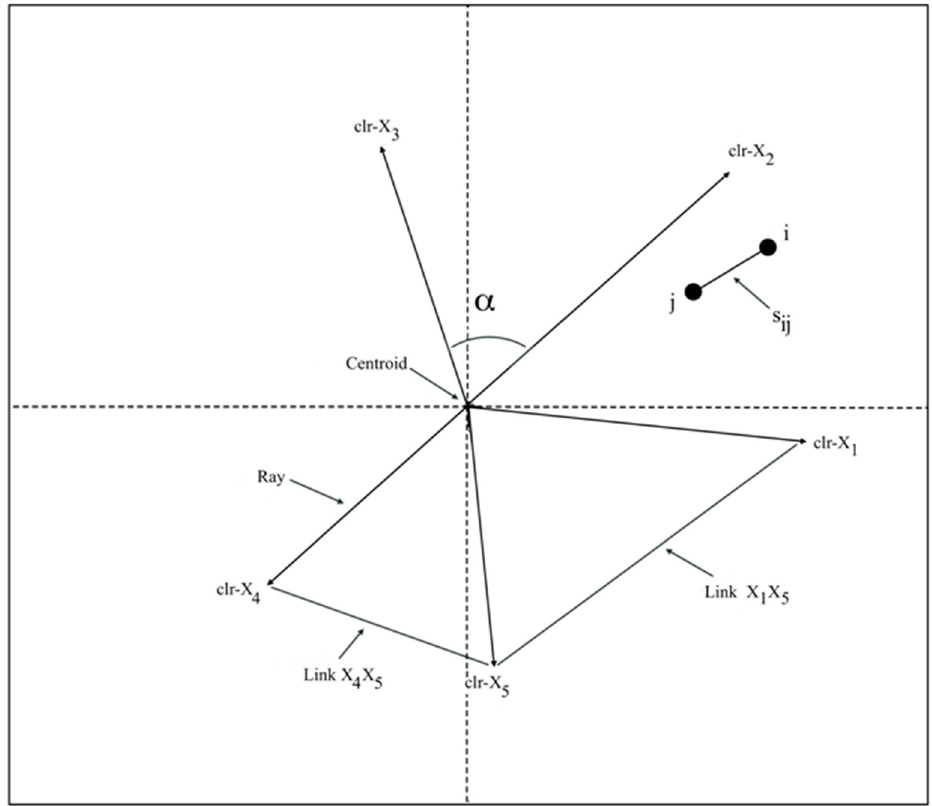
Figure 1. Elements of a compositional biplot.